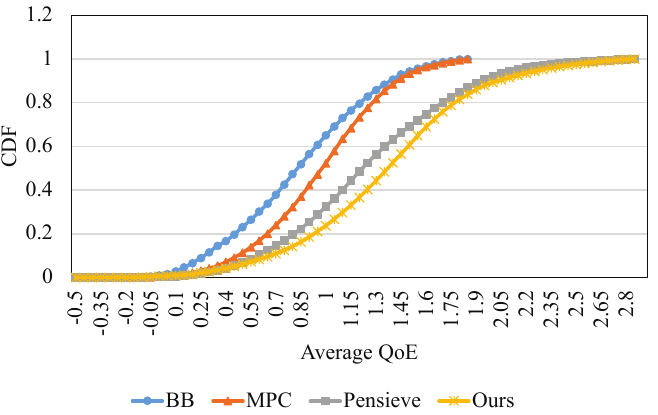
Figure 5. Cumulative distribution function (CDF) of QoE. It can be seen that our proposed SR- Telemedicine outperforms the baseline algorithms in the average QoE and can achieve a better QoE with a higher